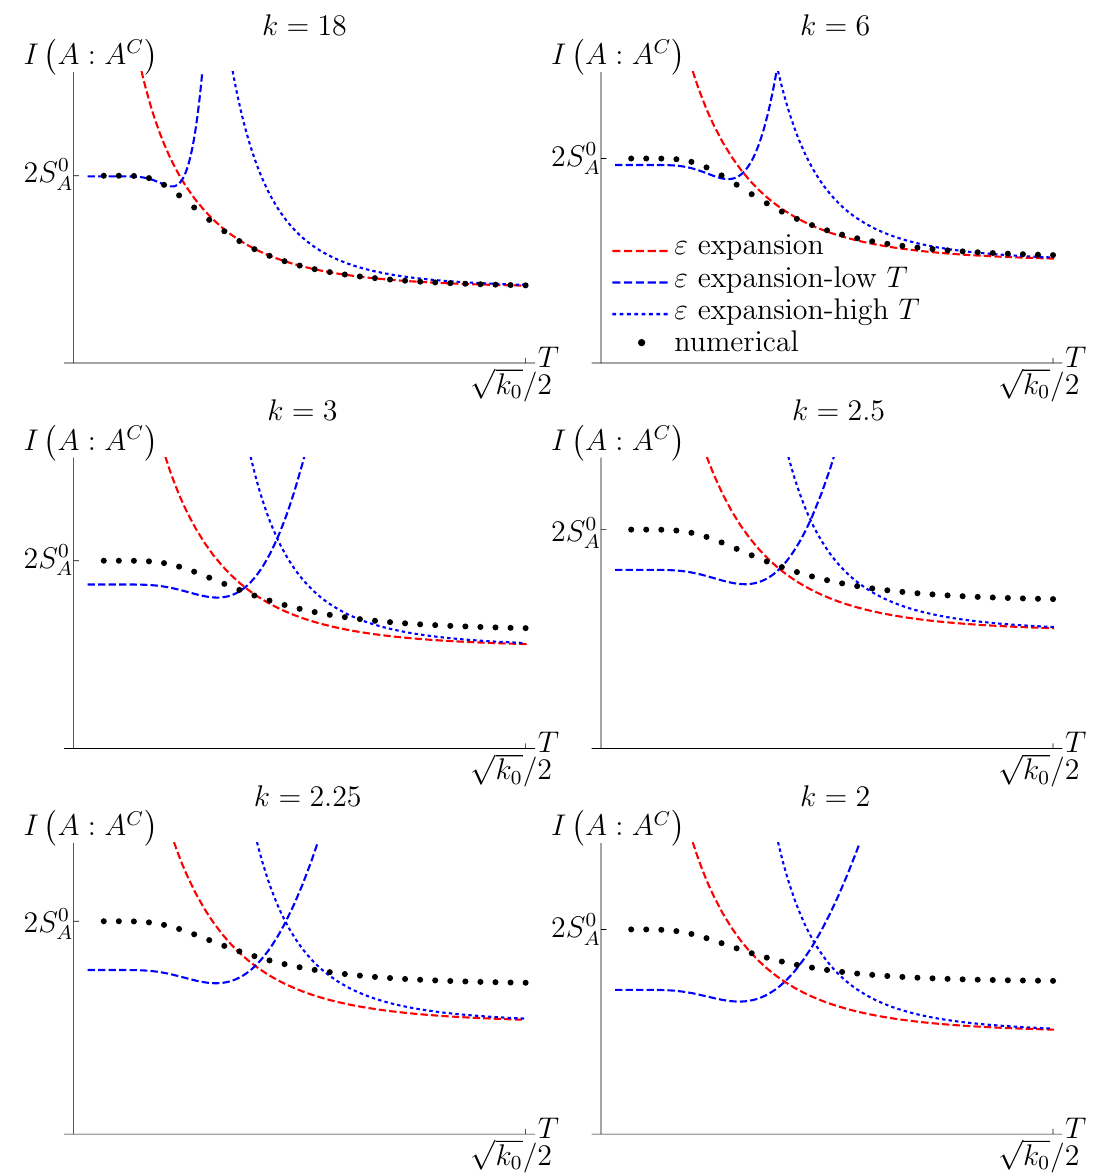
Figure 2 . The mutual information as function of the temperature for the chain of oscillators (4.37) for various value of the parameter k